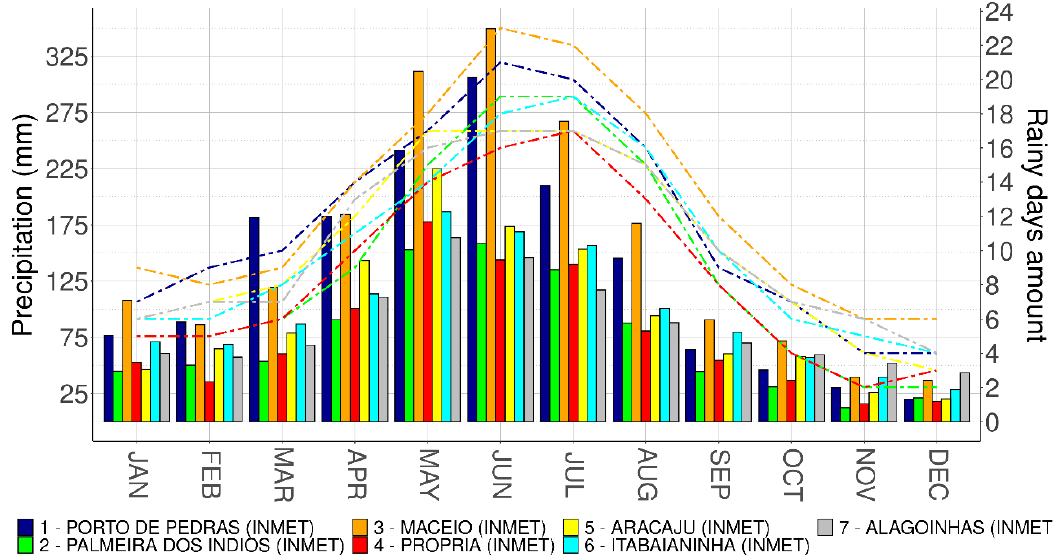
Figure 2. Monthly precipitation measured at the SEALBA stations averaged over the period 2000– 2020 (columns, left axis) and number of days with precipitation greater than 1 mm (dashed lines, right axis).